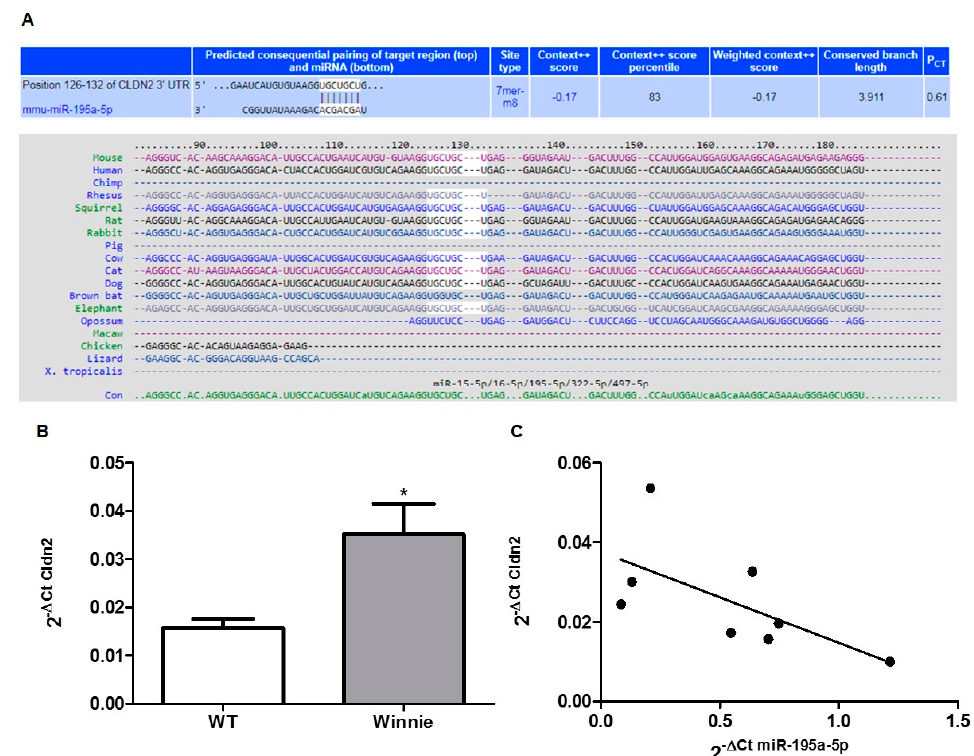
Figure 3. miR-195a-5p targets CLDN2. ( A ) Sequence alignment of the miR-195a-5p base-pairing sites in the 3’-UTR of Cldn2 mRNA showing that the regions complementary to miR-195a-5p are highly conserved among mouse, human, and chimp. The “seed” sequences of miR-195a-5p complementary to Cldn2 are shown in white. ( B ) Cldn2 mRNA expression levels evaluated in the same set of RNA samples used in the microarray validation. Cldn2 levels were significantly higher in Winnie mice compared to wild-type mice. Cldn2 expression levels were normalized on the housekeeping gene Gapdh. The histograms represent the mean ± SEM. * p = 0.03. (C) Linear correlation between the expression of Cldn2 and the expression of miR-195a-5p. Cldn2 mRNA levels inversely correlated with miR-195a-5p expression levels. Black points represent correlation between mRNA and miRNA expression for each sample (r = − 0.64; p = 0.04).